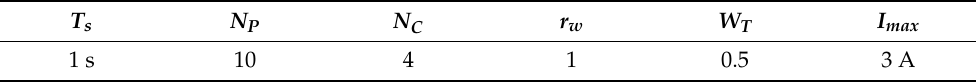
Table 5. Parameters of the implemented